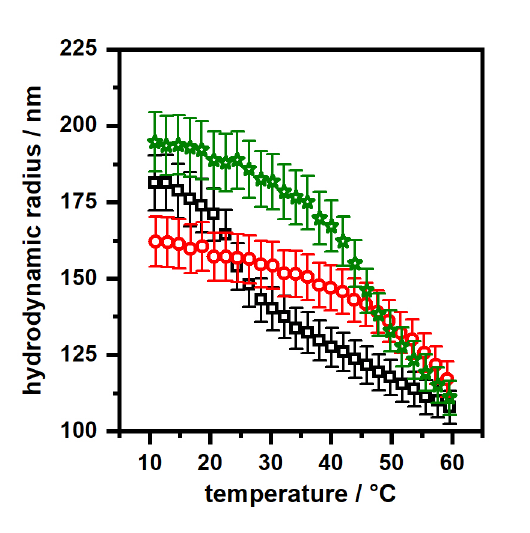
Figure A2. Comparison of the PCS swelling curves of the core microgels (red circles) and the core-shell particles PNN100/PMAM0 (black squares) and PNN0/PMAM100 (olive stars). All measurements were performed at